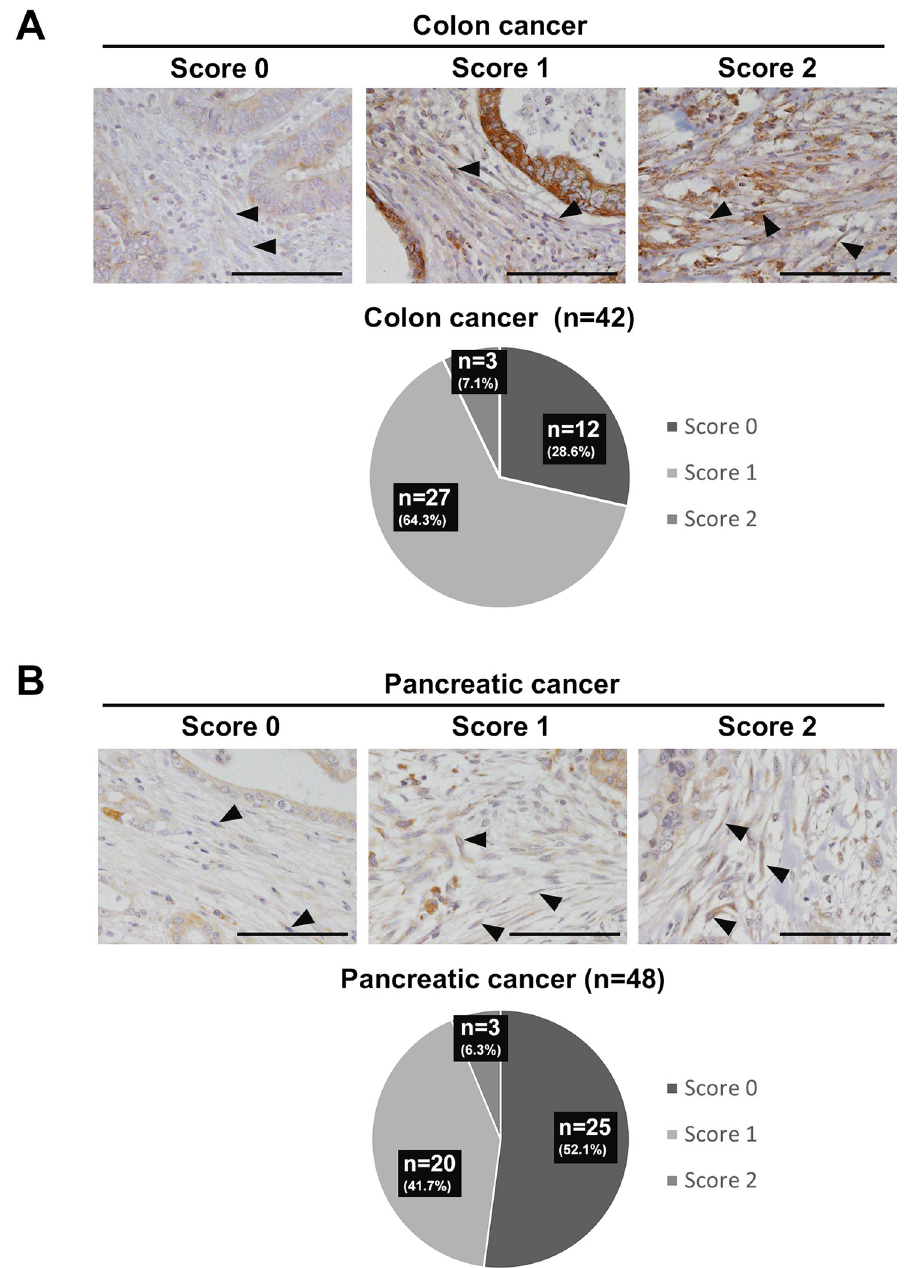
Fig 6. Fibroblast-specific exostosin-1 (EXT1) expression in the stroma of human colon and pancreatic cancers. (A) Scoring of human colon cancers (N = 42). Arrowheads indicate Ext1-positive fibroblasts. Scale bar = 50 μ m. (B) Scoring of human pancreatic cancers (N = 48). Arrowheads indicate Ext1-positive fibroblasts. Scale bar = 50 μ m.